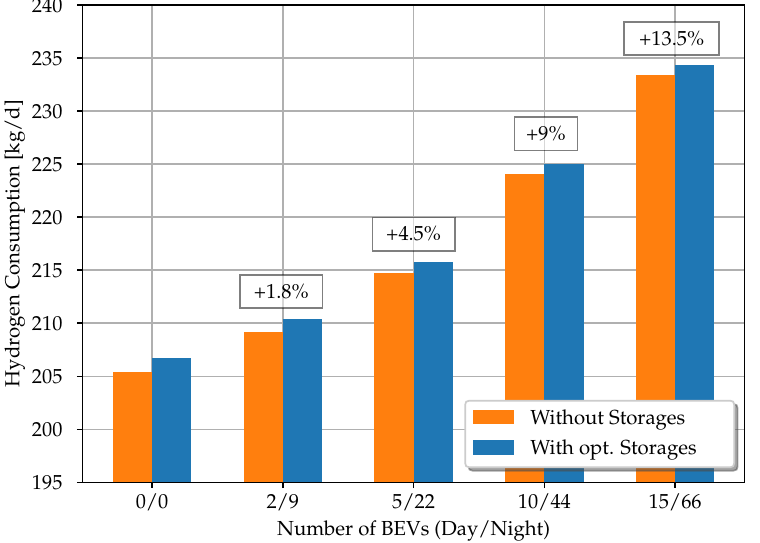
Figure 7. Analysis of the average daily hydrogen demand for the scenarios considered. Shown in blue are the respective scenarios without storage systems. In orange, the individual scenarios with optimally dimensioned storage capacities. The X-axis shows the scenarios considered resp. the relative number of employees in the neighbourhood who use a BEV daily for commuting and charge it in the neighbourhood during the other half of the day according to their working hours. The information in the brackets behind the percentage figure indicates the period in which the cars are charged